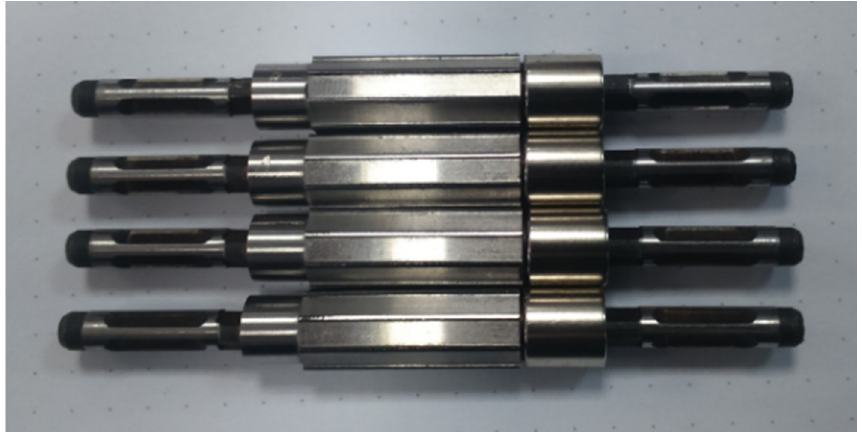
Figure 13. Actuator components made with AM technology ready for integration: primary control spools.